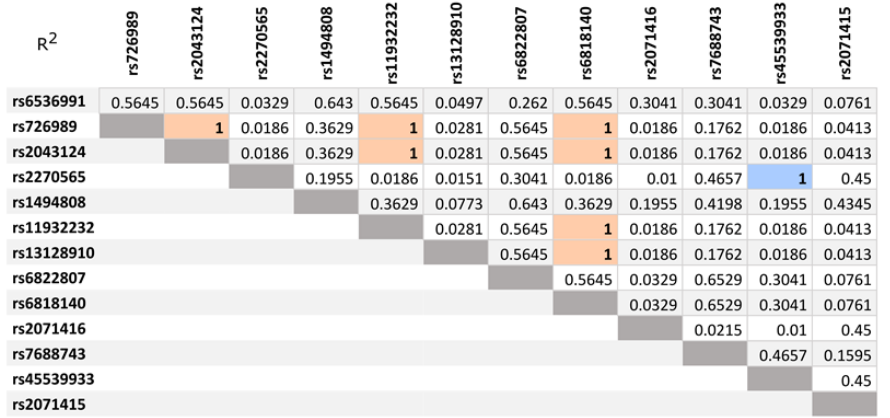
Figure 1. LD analysis of UCP1 gene variants identified in the coding region based on data from the LDpair tool. LD blocks are marked by colors.